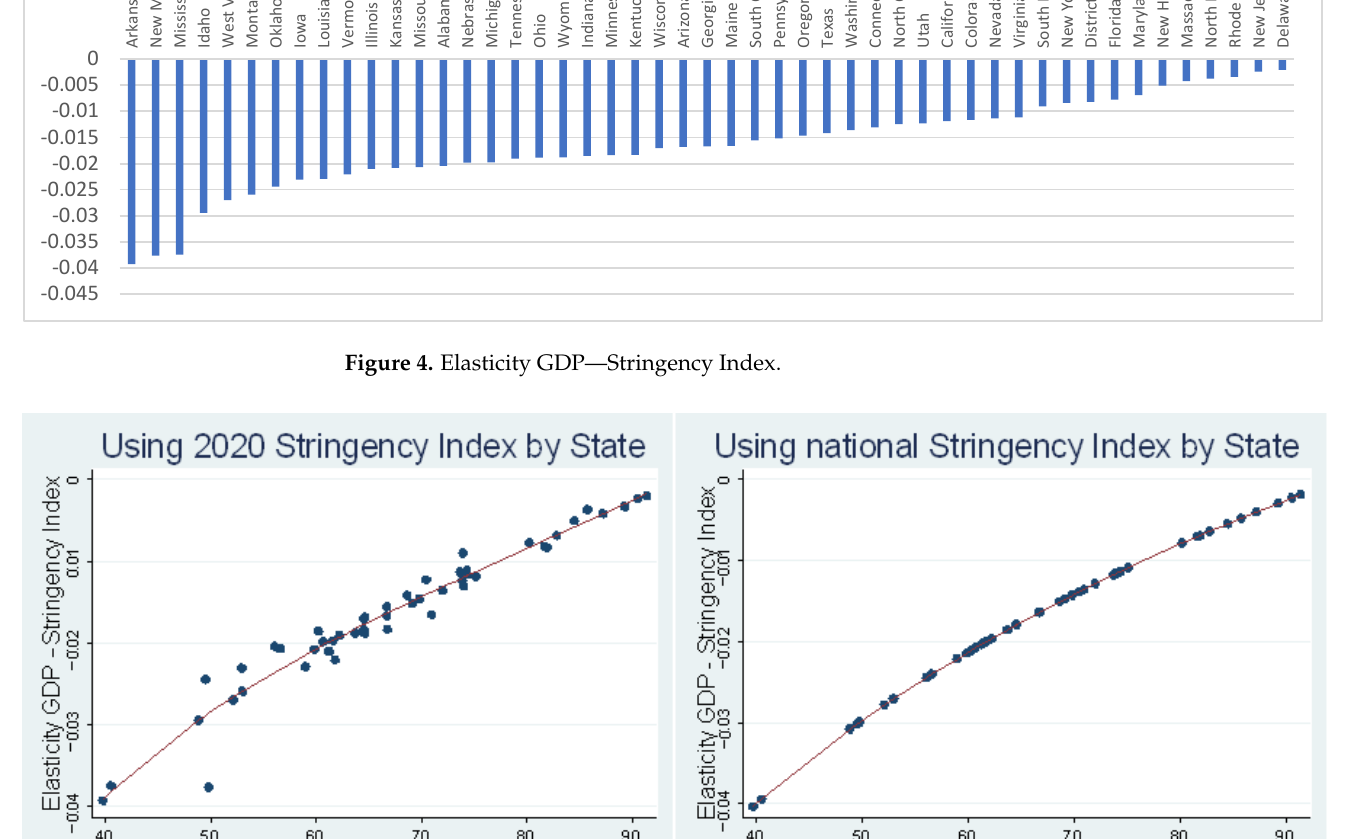
Figure 5. Elasticity GDP — Stringency Index by level of BB penetration.